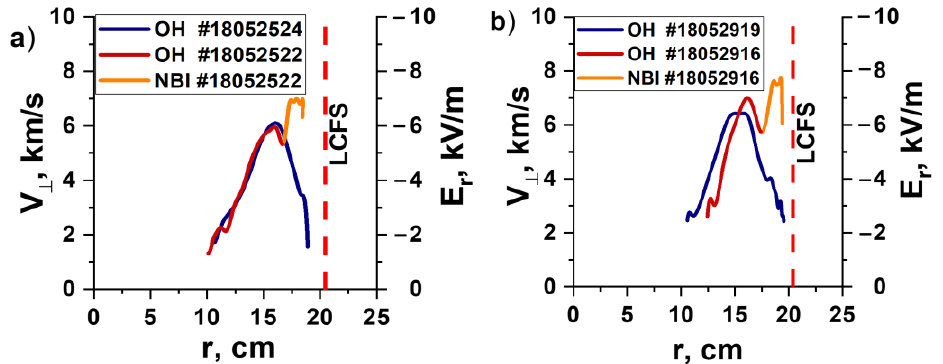
Figure 8. Radial profile of the rotation velocity and radial electric field for pairs of discharges with and without NBI.